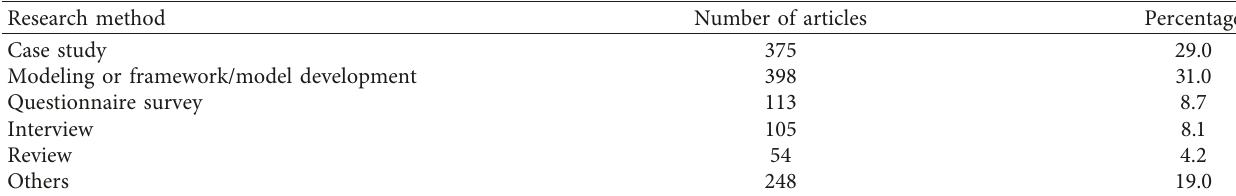
Table 8: Summary of research methodologies in the literature sample.